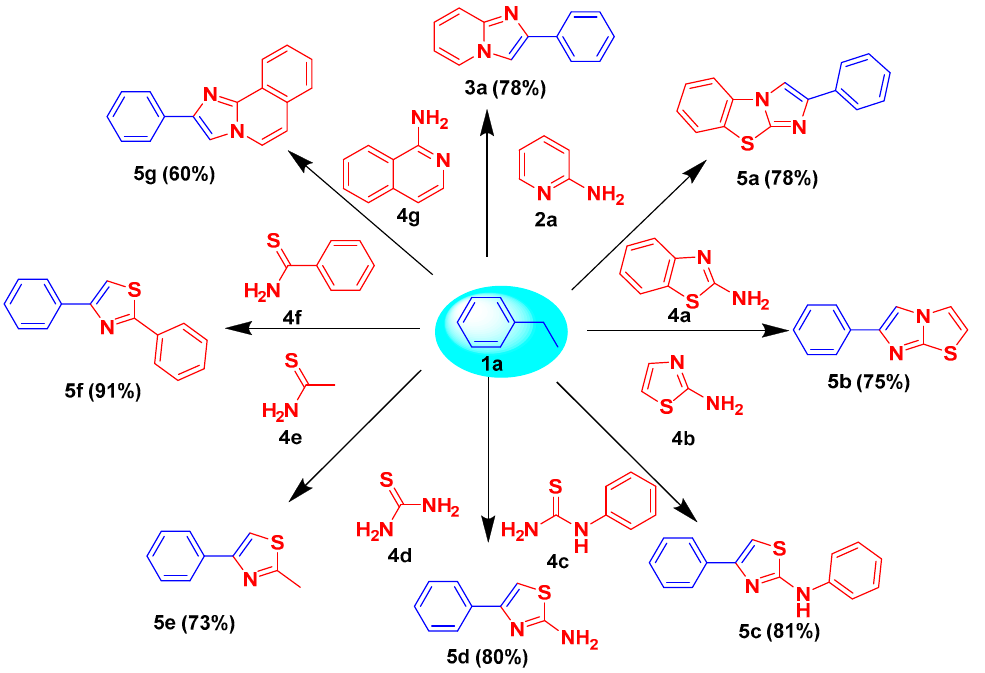
Figure 2. Substrate scope for diverse imidazoles and thiazoles.